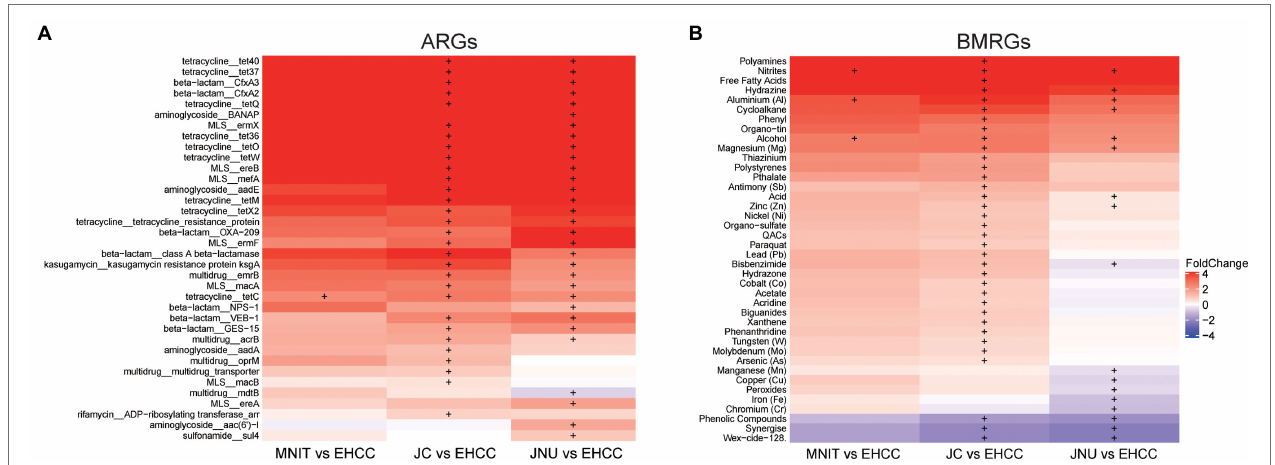
FIGURE 4 | Differentially abundant ARGs (A) and BMRGs (B) among influents. Heat map illustrates the fold change of ARGs/BMRGs abundance between influents of MNIT/JC/JNU vs. influent of EHCC. Positive fold change means higher abundance of ARGs/BMRGs in influents of MNIT/JC/JNU, otherwise ARGs/BMRGs enrich in influent of EHCC. The significance computed by Welch’s t -test was shown with plus sign. Only the ARGs subtypes or BMRGs types with average abundance > 0.01 copy per cell, and with significantly differential abundance in no less than one comparison was shown. MLS, macrolide-lincosamide- streptogramin; QACs, quaternary ammonium